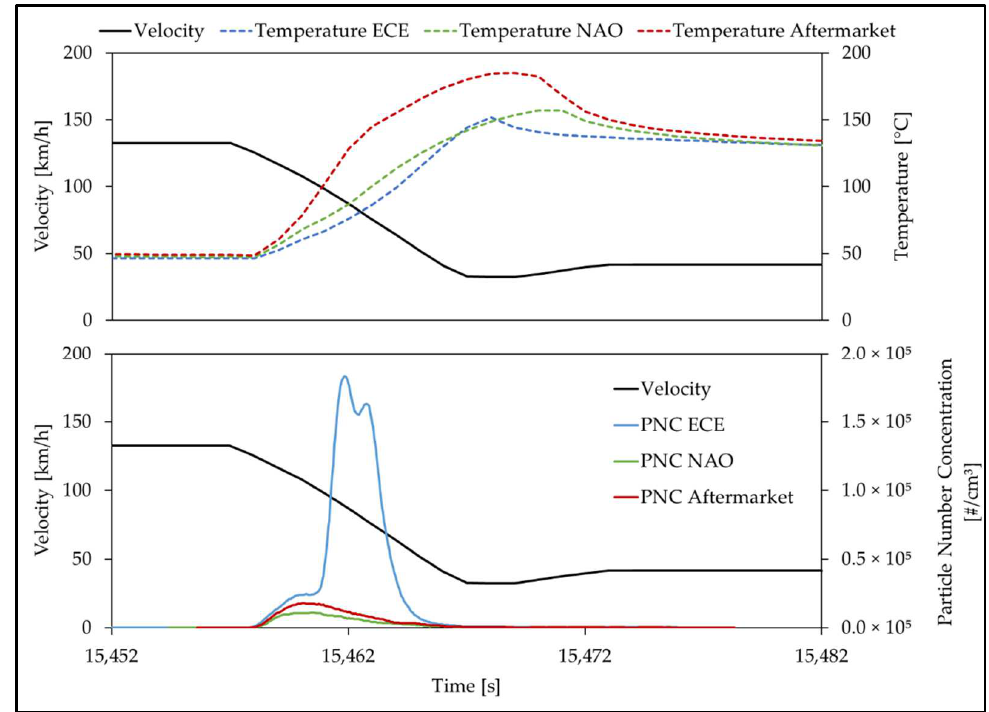
Figure 7. Evolution of temperatures and particle number concentrations (SPN measured with CPC) during WLTP Brake Cycle Trip 10 brake event #106.